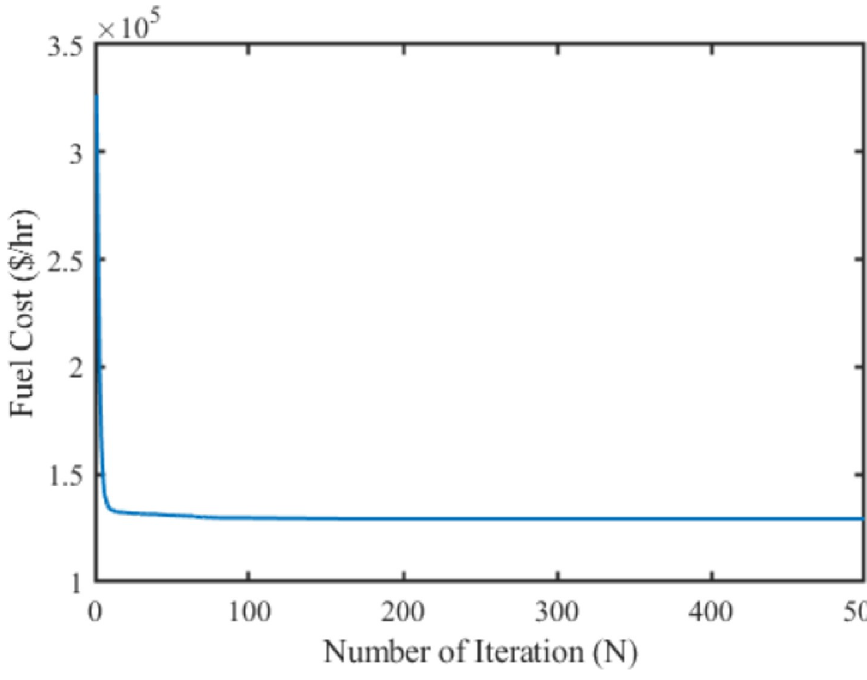
Fig 9. IEEE 118-bus convergence